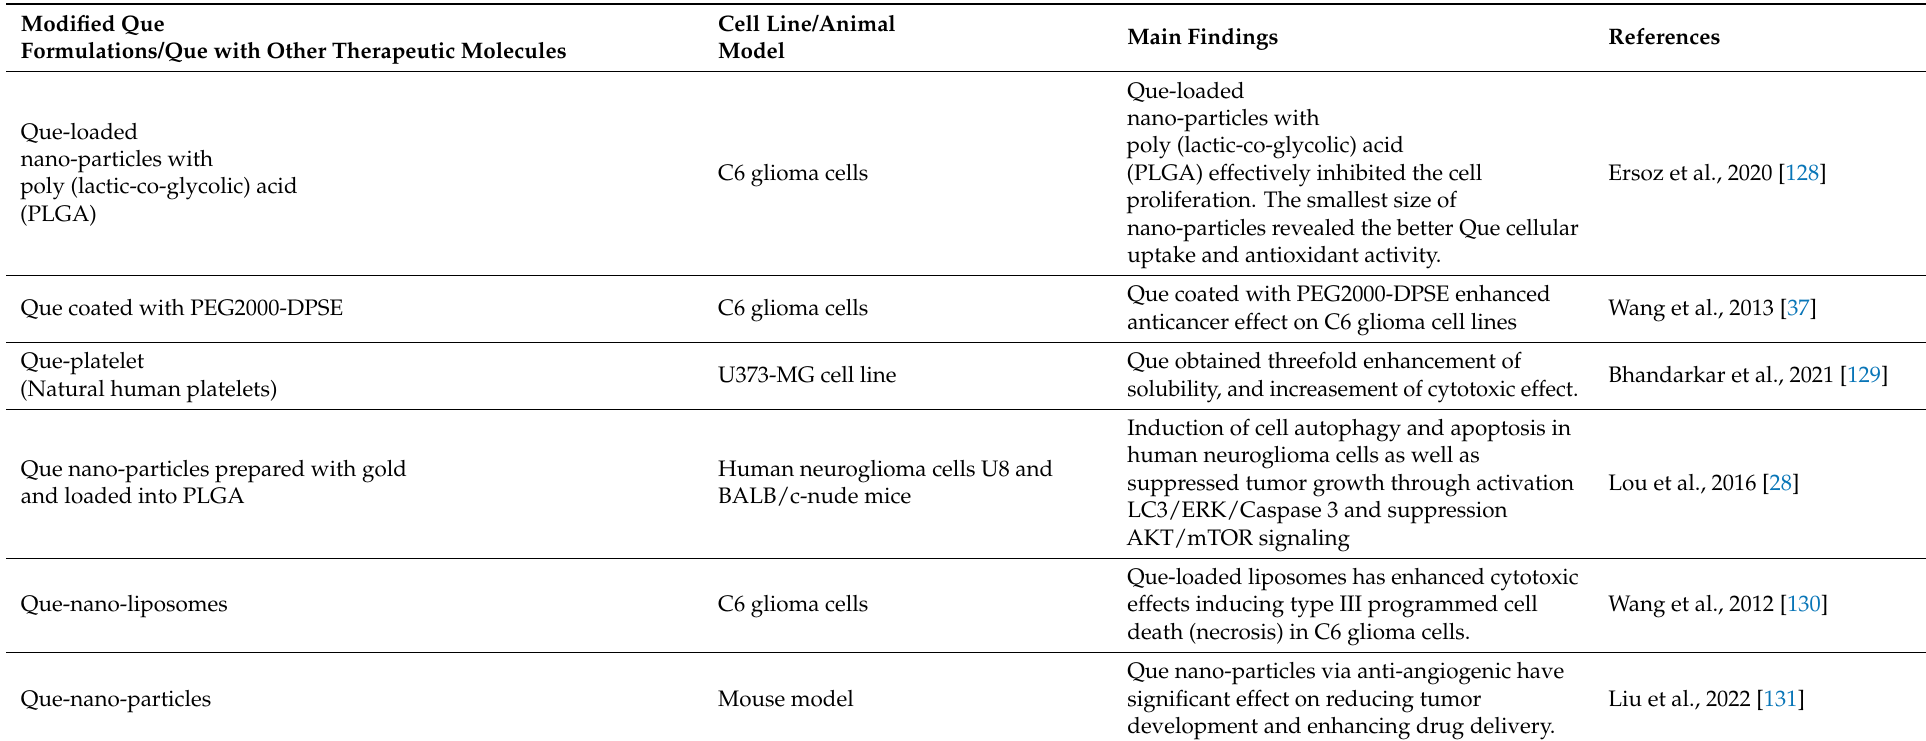
Table 3. Novel formulations of Que and their effect on glioma and glioblastoma cell